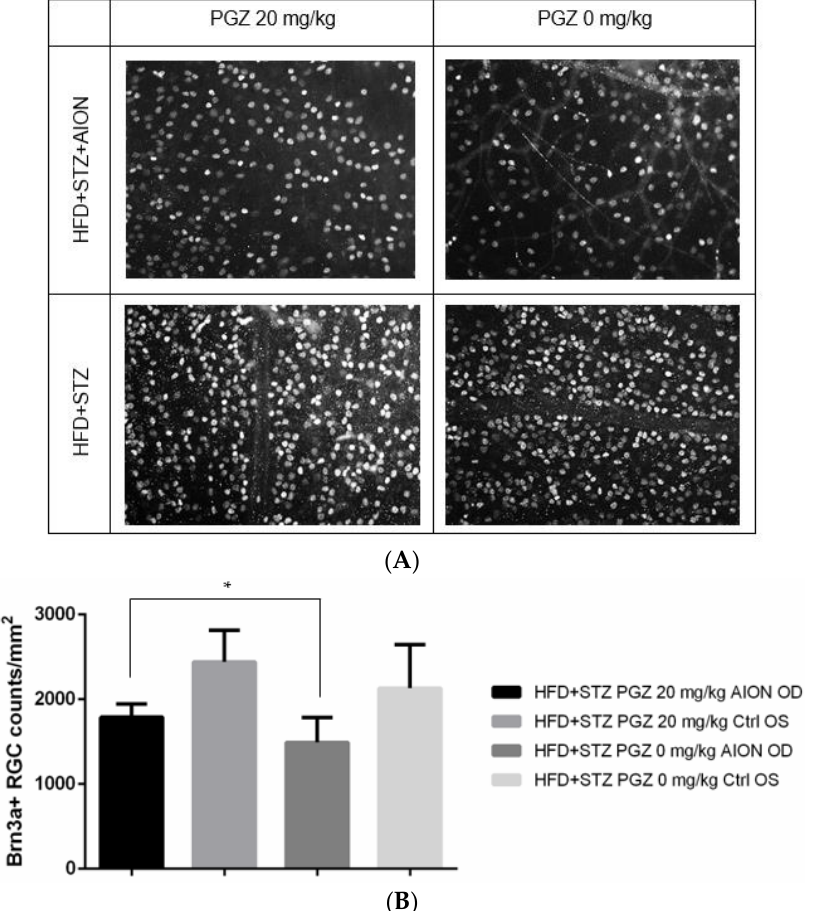
Figure 6. Brn3A + RGCs in diabetic mice. ( A ) Representative images of immunostaining by using anti-Brn3A antibody in retinal whole-mount preparations of control and AION eyes of diabetic mice treated with 20 and 0 mg/kg PGZ 3 weeks after AION (magnification: 200×). ( B ) Bar graph showing average Brn3A + cell counts in all 4 conditions 3 weeks after AION (* p < 0.05).